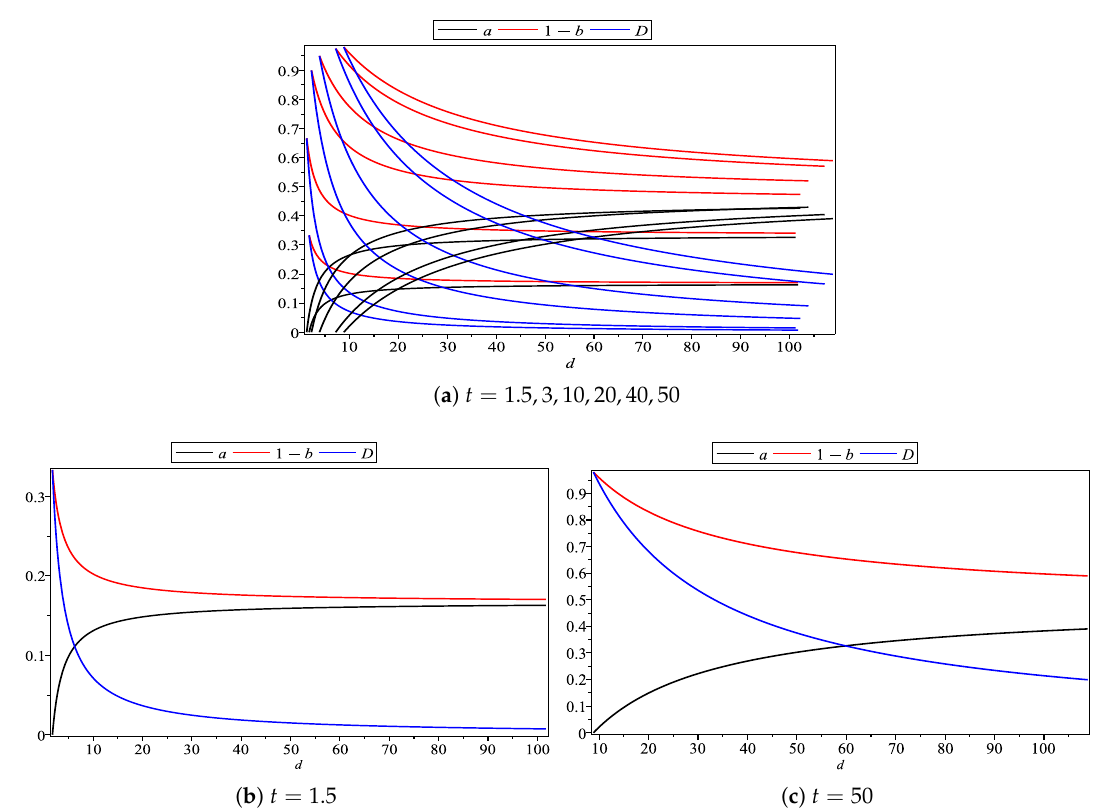
Figure 4. Social effect of CEA on the products’ environmental quality difference.